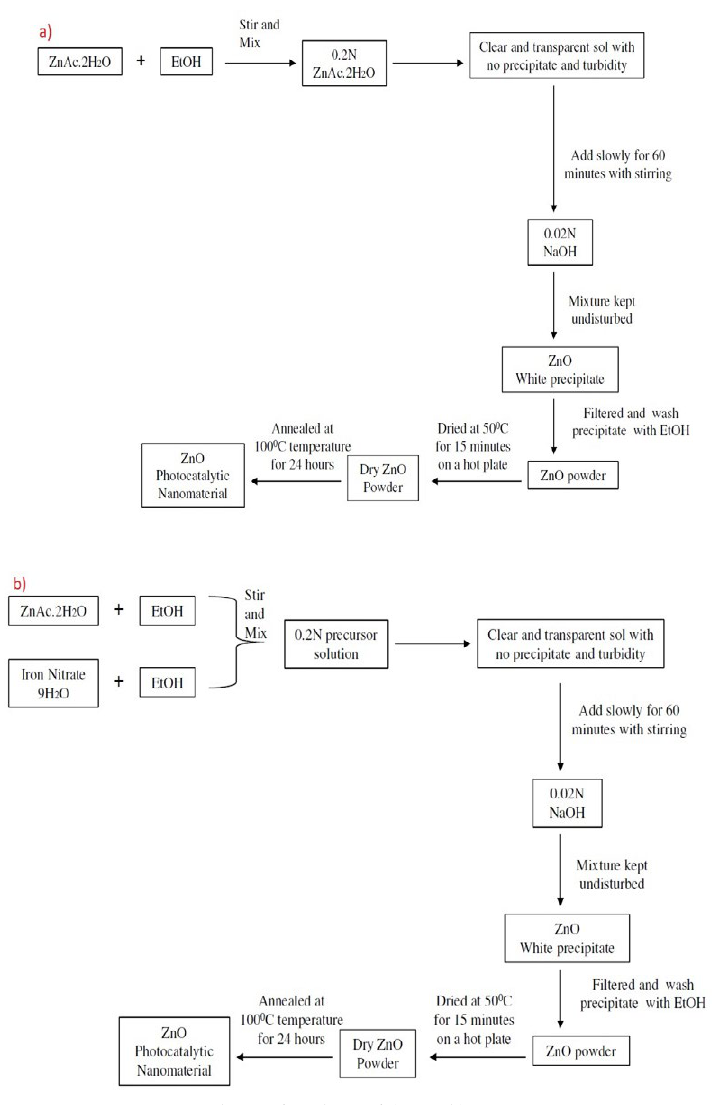
Fig. 2. Scheme of synthesis of a) ZnO b) 2% Fig.2. Scheme of synthesis of a) ZnO b) 2% Fe-ZnO